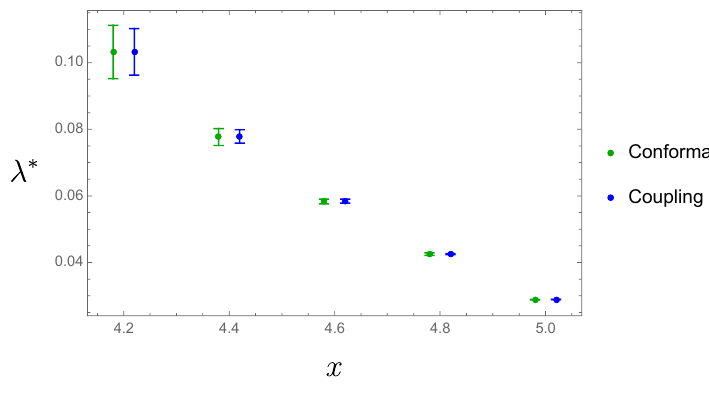
Figure 5 . The (cid:12)xed point coupling as a function of x = n f =n c in the Veneziano limit. The central values and error bars refer to the Pad(cid:19)e-Borel approximants [1 = 2] in the conformal expansions and [2 = 2] in the coupling expansion. For both ordinary coupling and conformal expansions the error bars correspond to c np =